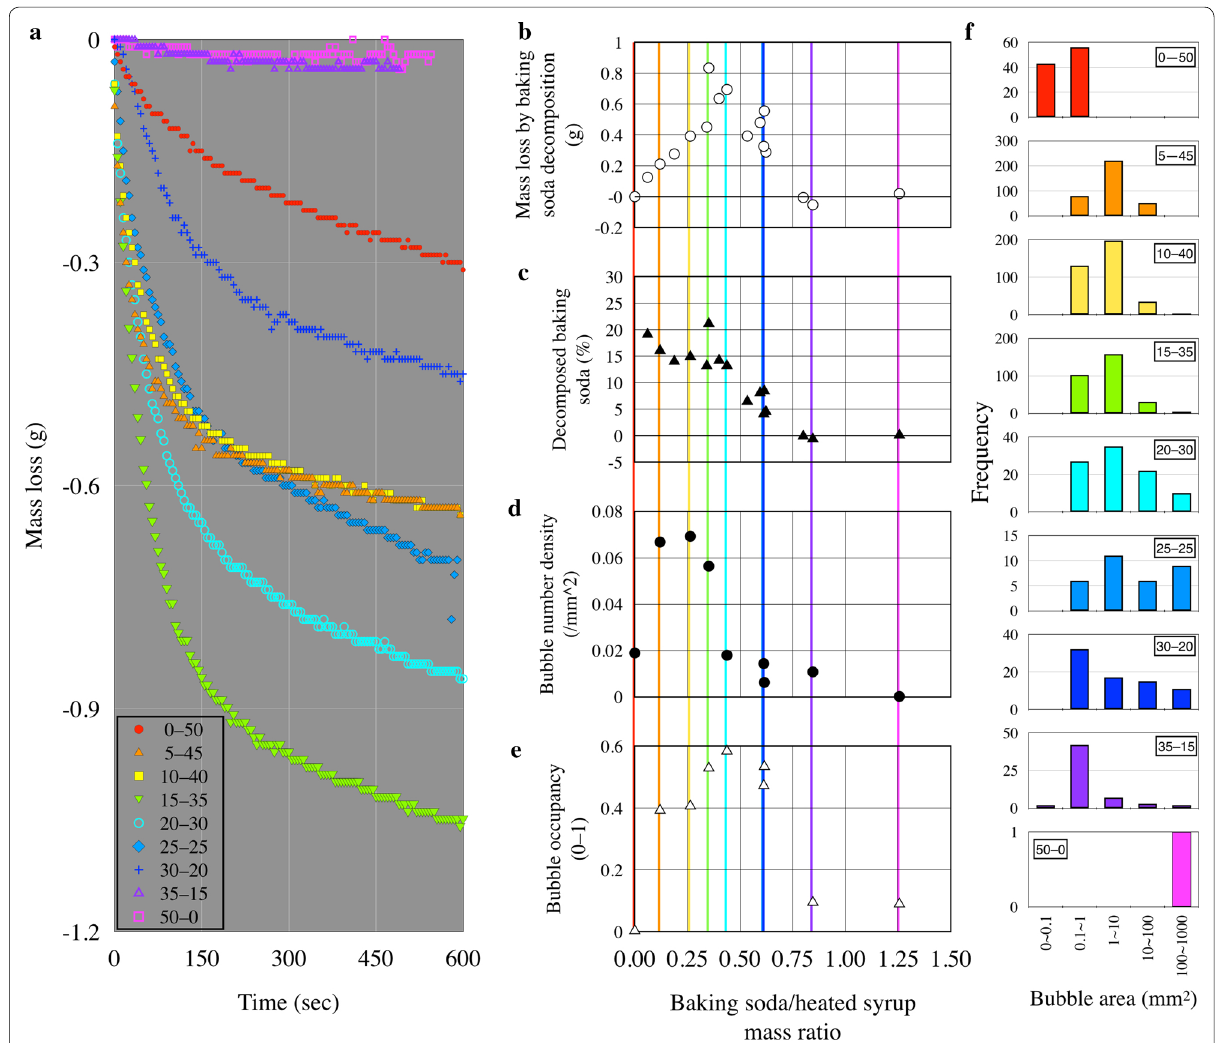
Fig. 1 Experimental results. a Mass changes of the system during experiments. Relationship between the mass ratio of baking soda/poured heated syrup and b mass losses caused by baking soda decomposition, c percentage of decomposed baking soda, d bubble number density, and e bubble occupancy in a petri dish. f Bubble size and number for each substrate composition. Colors correspond to substrate composition, as shown in the legend in a . S mass of baking soda (g), C mass of cake syrup = =